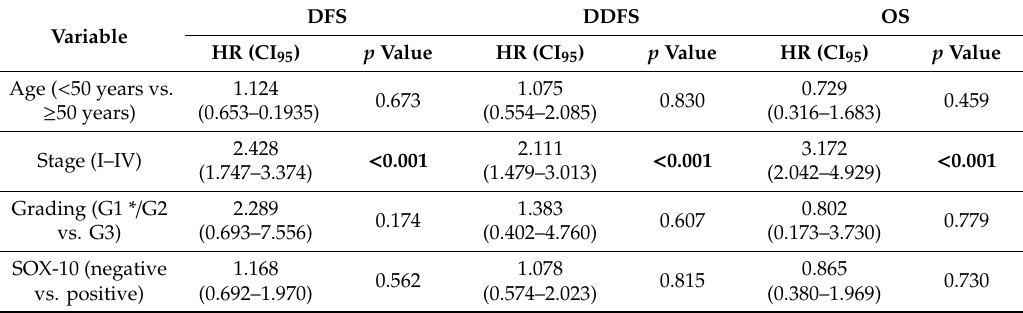
Table 4. Multivariate survival